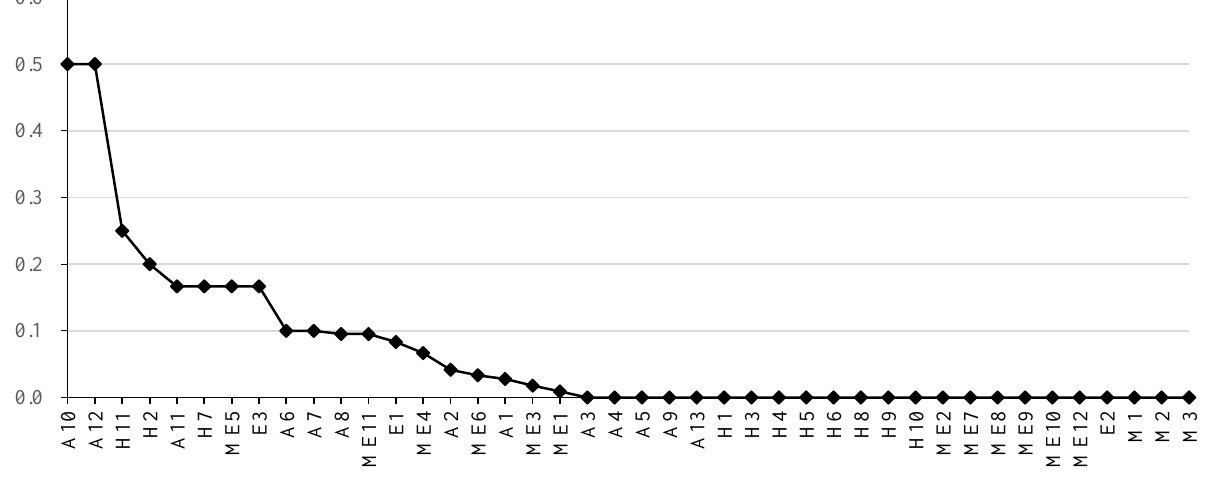
Figure 7. Values of clustering coefficients.